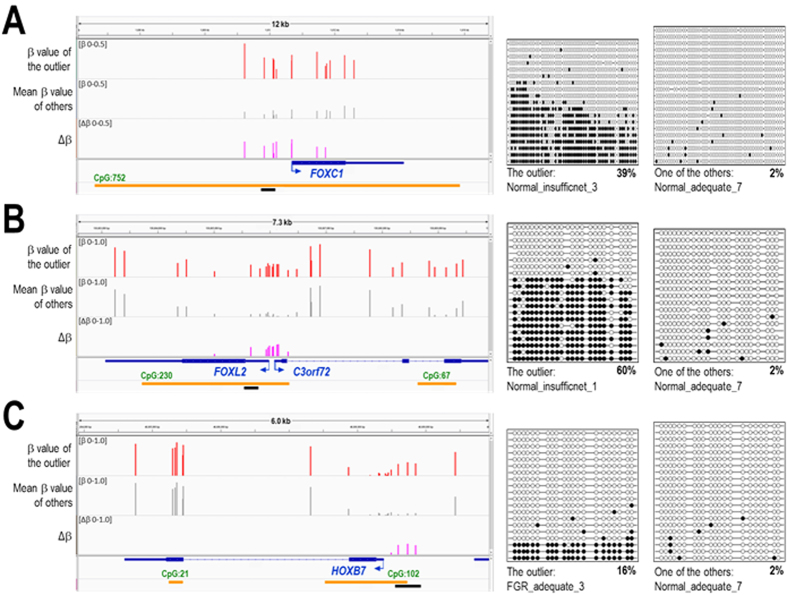
Examples of promoter-wide hypermethylation at FOXC1 (A), FOXL2 (B), and HOXB7 (C) loci. The β value of the outlier, the mean of the β values of samples other than the outlier, and the Δβ are shown together with Refseq gene and UCSC-defined CGIs using IGV at the left side in each panel. The data range of 0 to 0.5 (or 0 to 1.0) is shown for β and Δβ values. The outlier samples for the three loci are Normal_insufficient_3 (A), Normal_insufficient_1 (B), and FGR_adequate_3 (C). DNA methylation status of these promoter regions were validated by targeted bisulfite sequencing (BS). The black horizontal bar at the bottom in each panel shows the interval of the bisulfite-PCR amplicon. The BS results for the outlier sample and a control (Normal_adequate_7) are shown at the right side in each panel. Open and closed circles represent unmethylated and methylated CpG sites, respectively. Each row of circles corresponds to an individual clone sequenced. The overall methylation rate (%) is shown underneath each panel of the BS results.